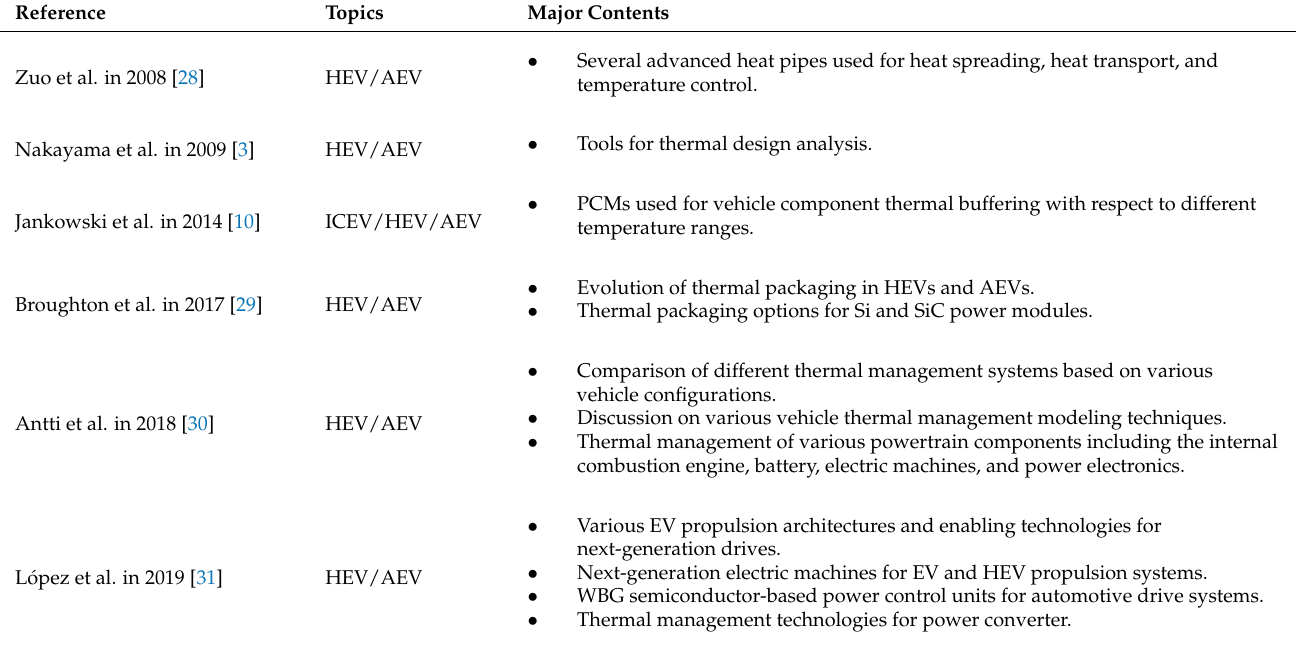
Table 3. Summary of the previous reviews concerning the TMS for electronics on board automobiles and